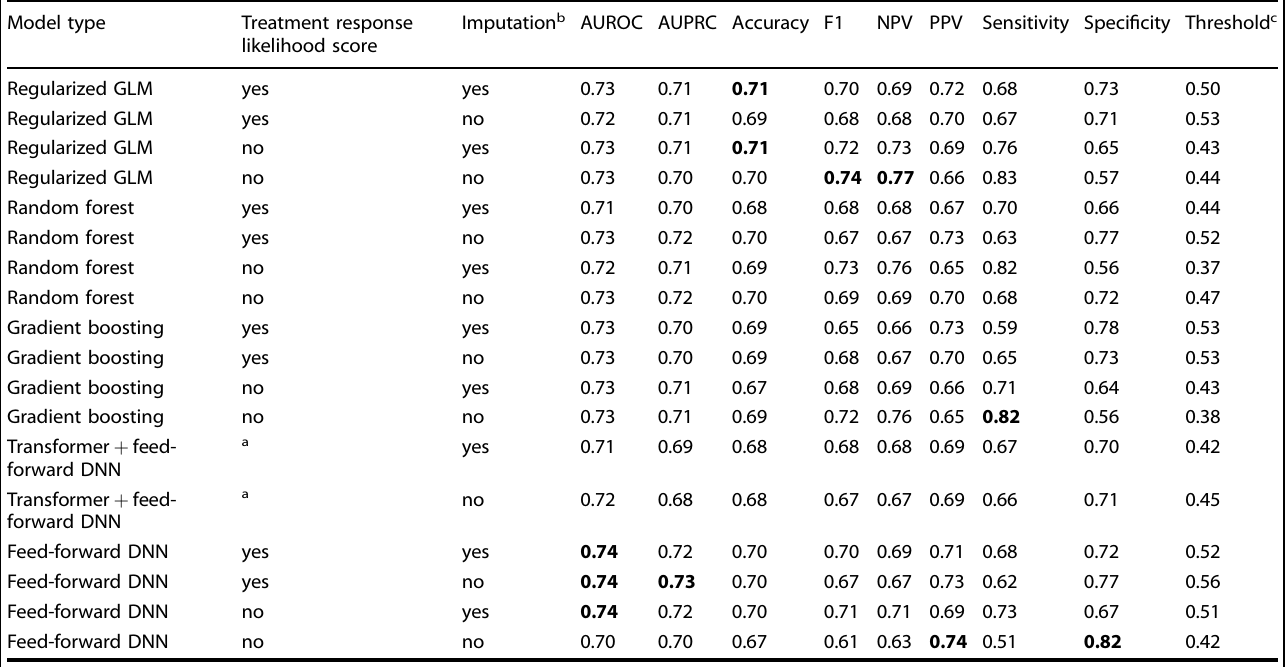
Table 2. Model performance metrics for antidepressant treatment response prediction.